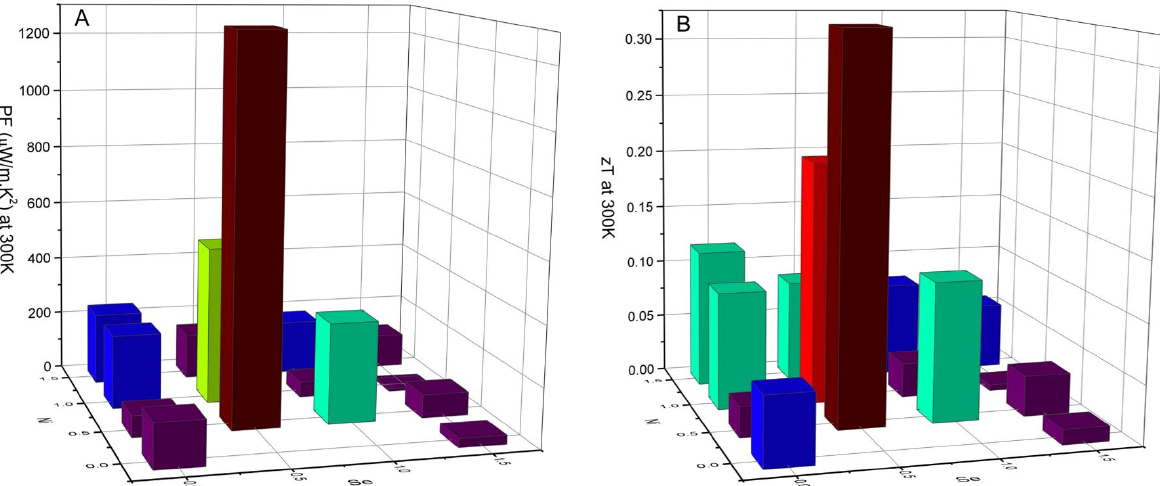
Figure 10. Power factor, PF, ( A ) and estimated figure of merit, zT, ( B ) at 300 K as a function of composition for the Cu 12 − x Ni x Sb 4 S 13 − y Se y annealed samples.